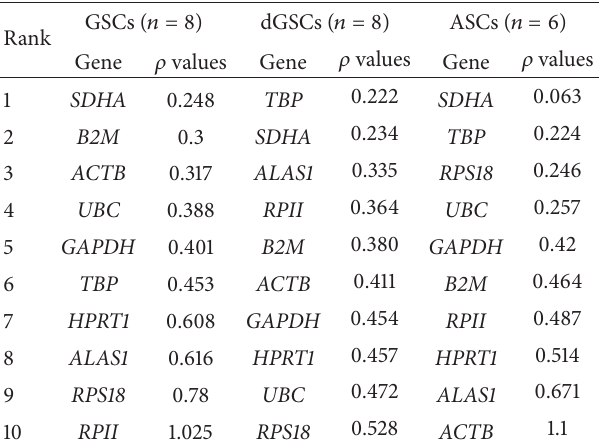
Table 6: NormFinder